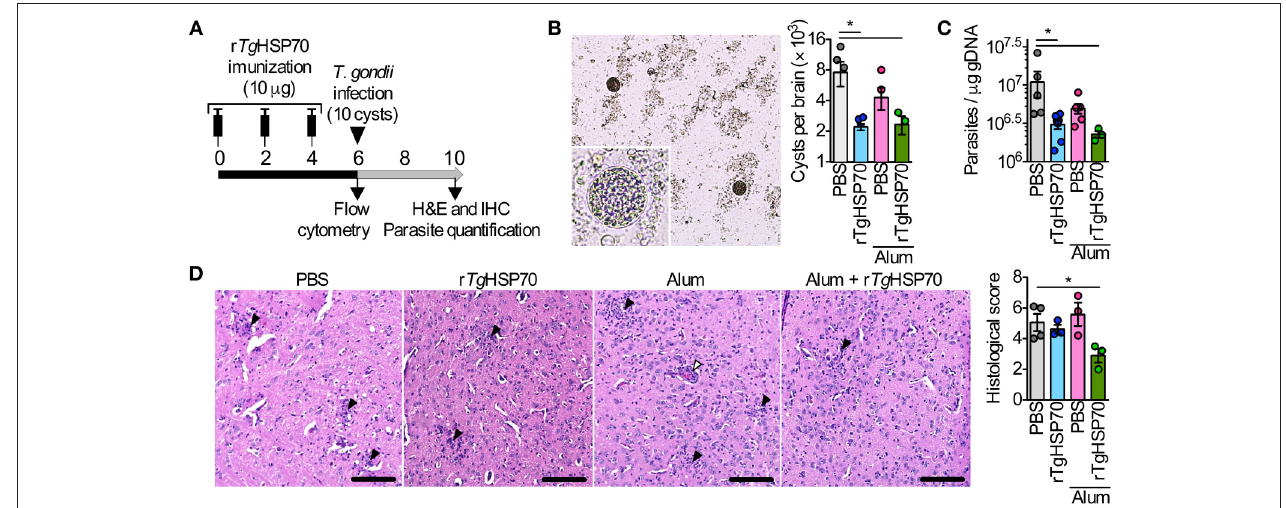
FIGURE 1 | Immunization with r Tg HSP70 reduces brain cyst numbers. (A) C57BL/6 mice were immunized with 10 µ g of r Tg HSP70 dissolved in PBS or adsorbed in Alum on weeks indicated. After 6 weeks, mice were infected with 10 cysts of ME49 strain of T. gondii and were observed for 4 additional weeks. (B,C) Parasite quantification by counting cerebral cysts in fresh brain macerates (B) and by qPCR for T. gondii B1 gene in the brain (C) from mice infected. (D) Representative micrographs from brain sections and quantification of histological alterations. Inflammatory foci (black arrow heads) and perivascular mononuclear cells (white arrowheads) are pointed. Scale bars represent 100 µ m. Data are representative of two independent experiments with five mice per group. * P < 0.05, one-way ANOVA. Error bars indicate mean ±